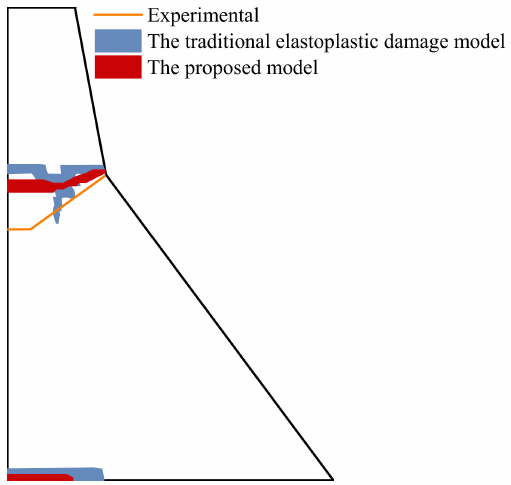
Figure 20. Comparison of the final cracking failure